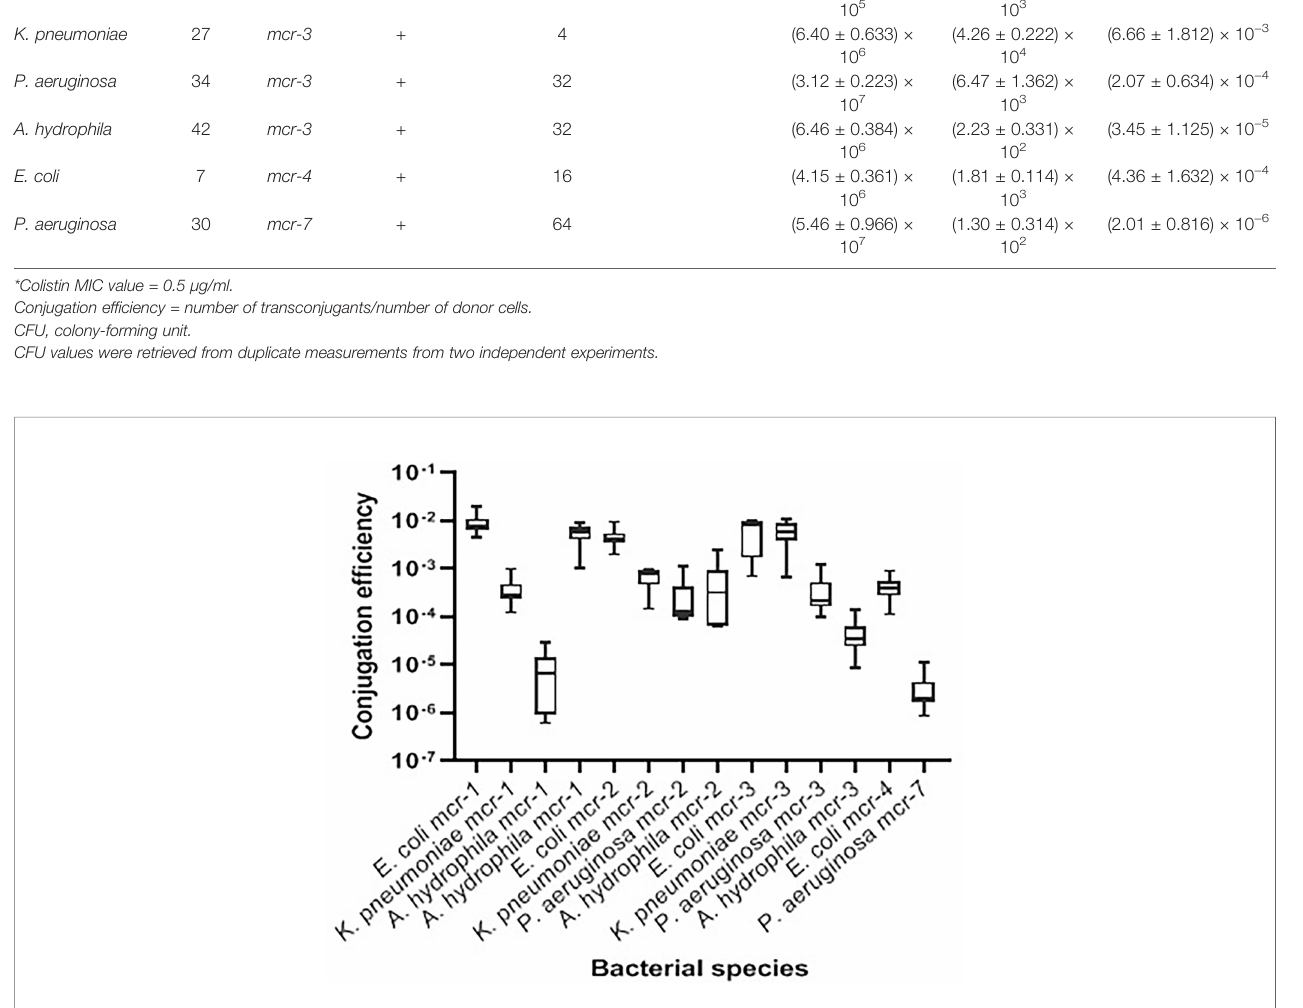
Frontiers in Cellular and Infection Microbiology |